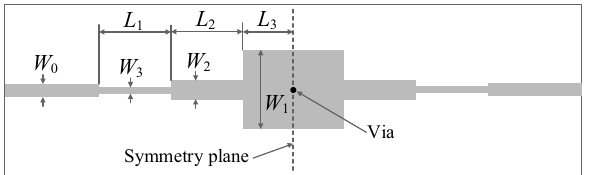
Figure 5. Geometry of the broadband bandpass filter with stepped-impedance resonator 63 .